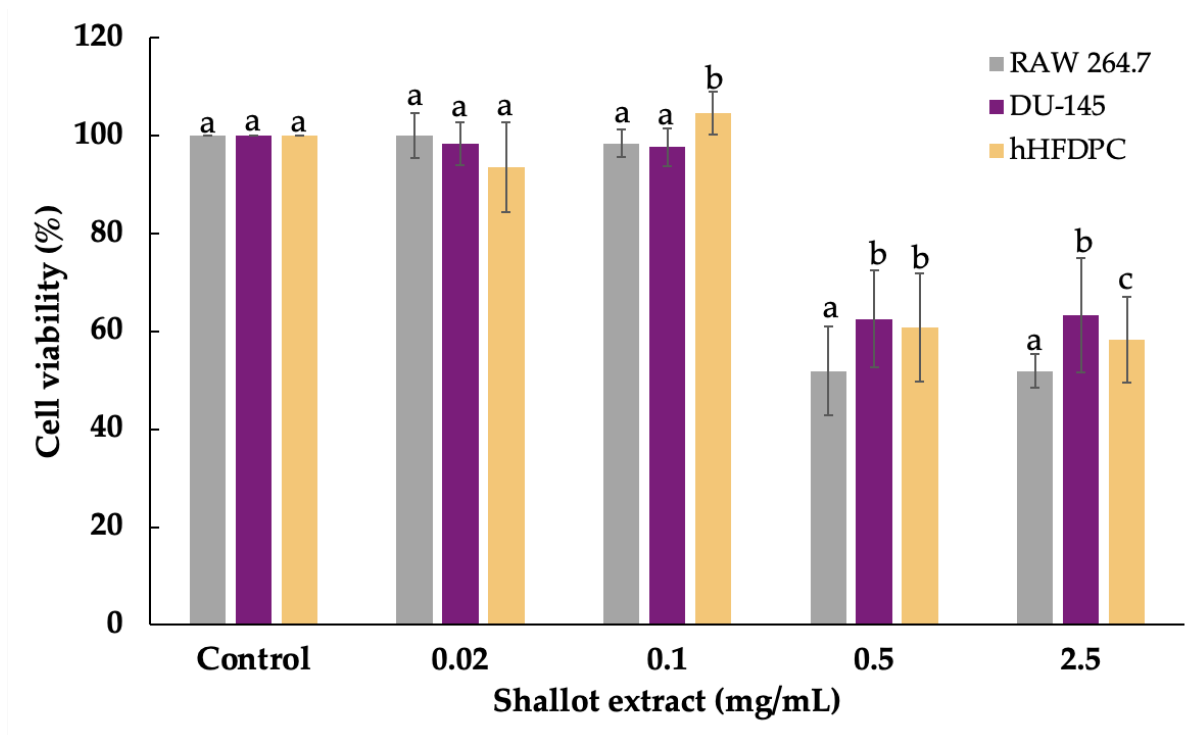
Figure 2. Cell viability of RAW 264.7 macrophage cells (RAW 264.7), DU-145 human prostate cancer cells (DU-145), and human hair follicle dermal papilla cells (hHFDPC) after shallot extract treatment for 24 h with different concentrations (0.02 to 2.5 mg/mL) was determined by sulforhodamine B (SRB) assay. Different letters (a, b, and c) indicate statistical differences ( p -value < 0.05) in the cell viability of each concentration.